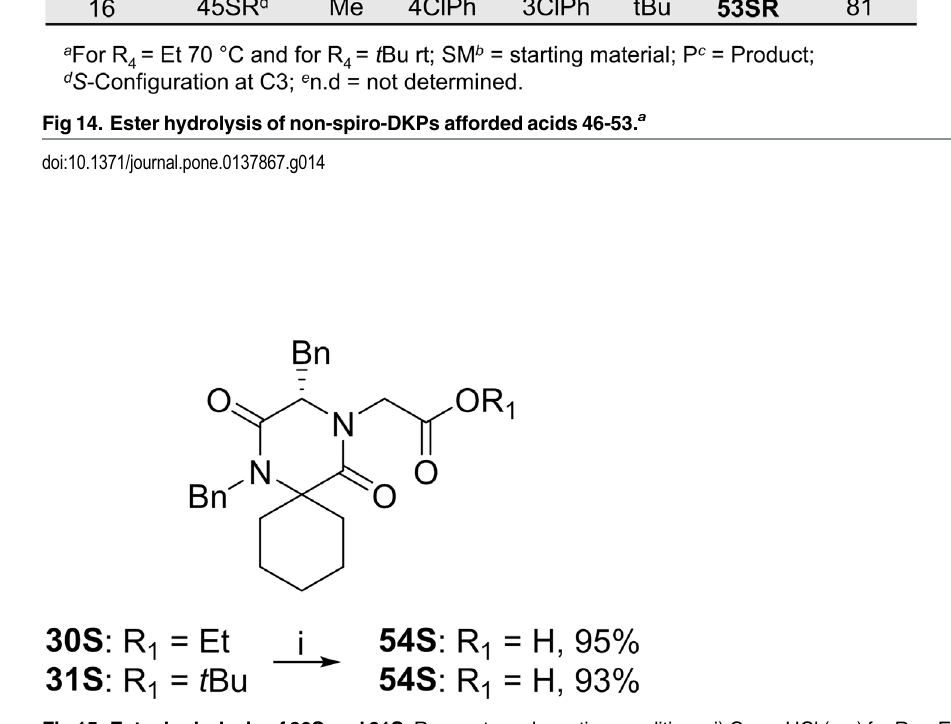
doi:10.1371/journal.pone.0137867.g015